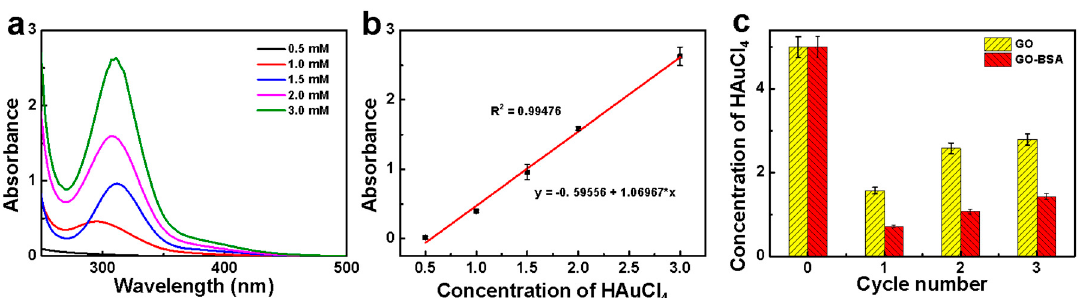
Figure 5. Removing AuCl 4 − ions: ( a ) UV-Vis spectra of the HAuCl 4 with different concentrations, ( b ) the relationship between UV absorbance and HAuCl 4 concentration at 310 nm, and ( c ) calculation of the concentration of HAuCl 4 after the filtration according to the standard curve. Inset: the illustration of the color change before and after the filtration of the GO–BSA membrane.